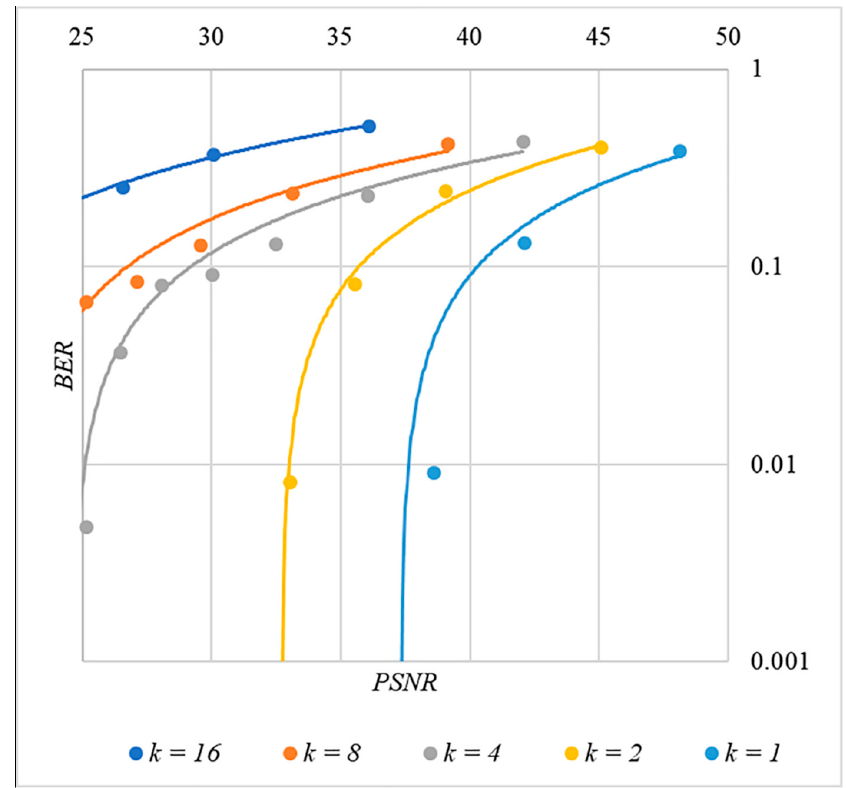
Figure 16. BER ( PSNR ) dependencies for different values k rule for generating chip codes № 4.